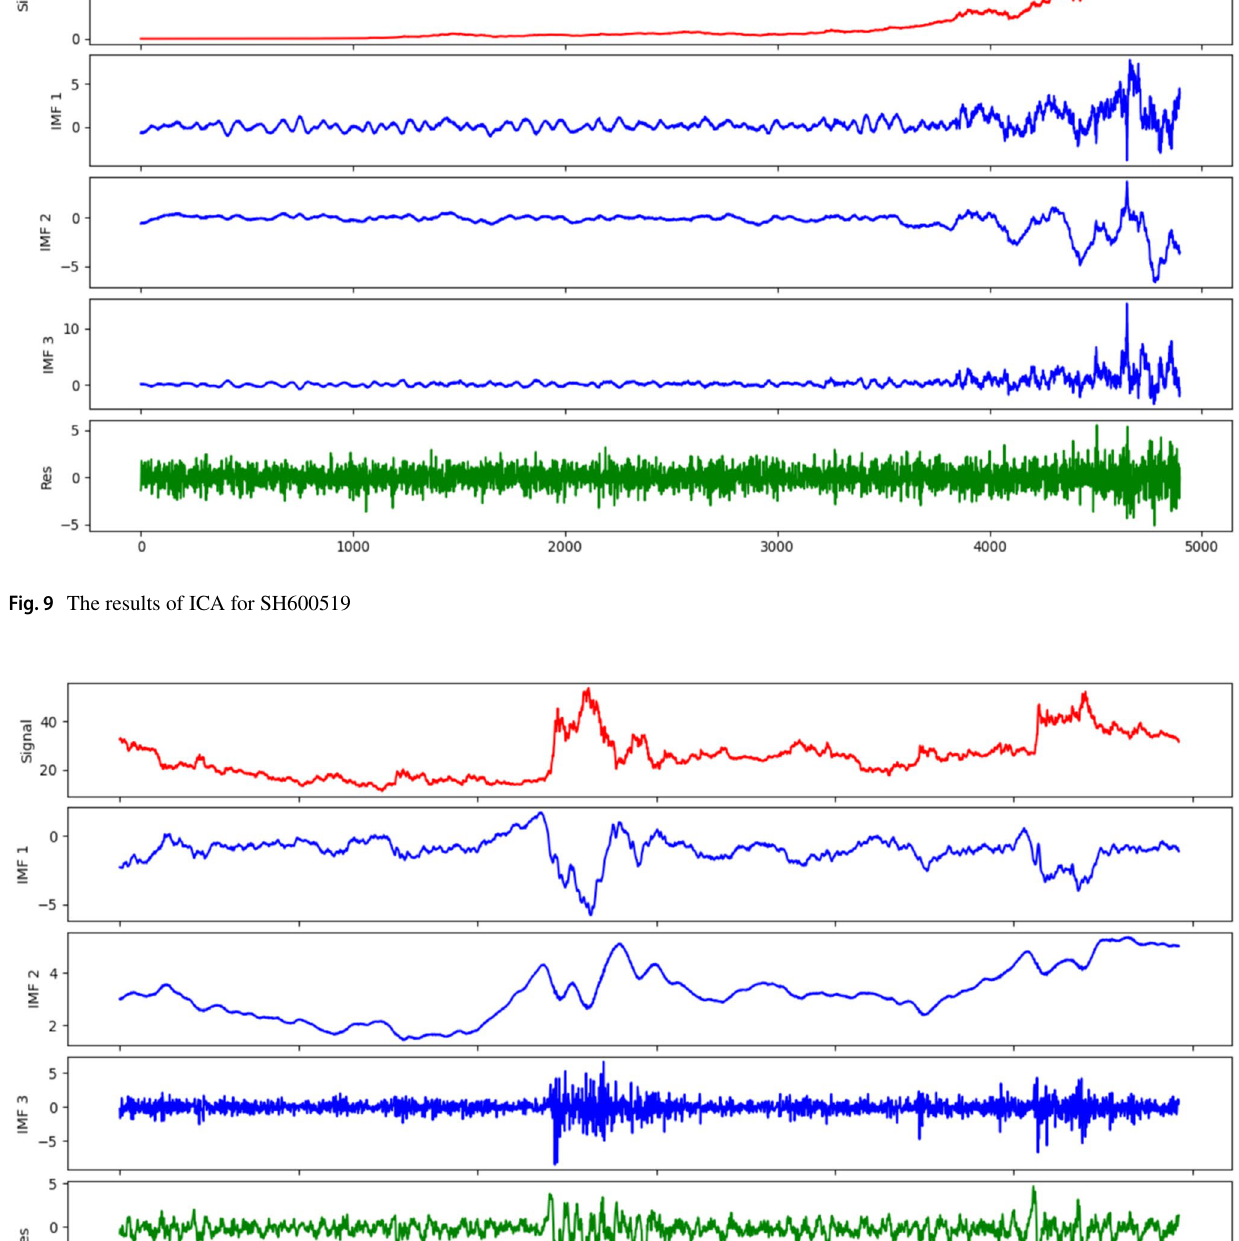
with the ARIMA, BP, and LSTM, the increase in MAPE of the CS-PSO-LSTM model for SH601988 in the 3-step forecasting is 80.60%, 78.37%, and 50.18%, respectively, demonstrating the positive influence of the CS on the ENN model. As a result, the CS-PSO-